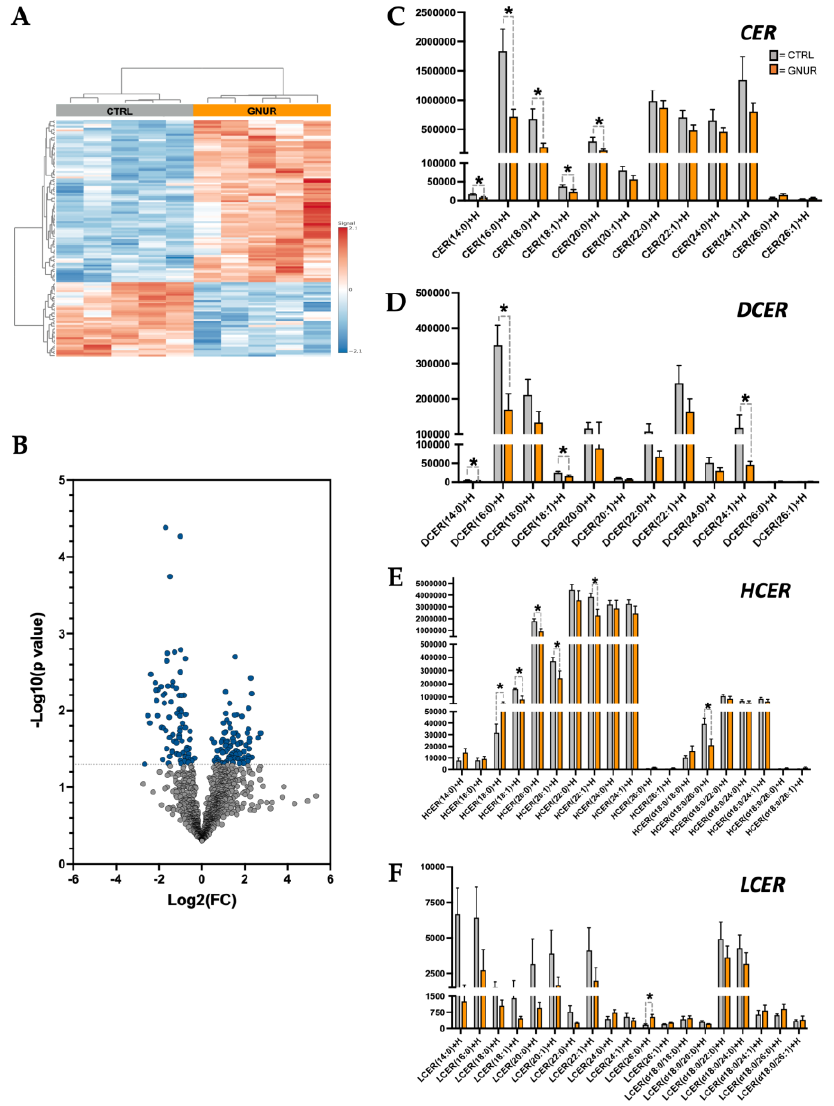
Figure 4. Lipidomics analysis of lipid species from the livers of GNUR- and CTRL-treated obese mice. ( A ) The heatmap of lipid species significantly changed in GNUR- and CTRL-treated obese mice. ( B ) Volcano plot of lipid species from lipidomics analysis of livers from GNUR- and CTRL- treated obese mice. ( C – F ) Sub-lipid species levels from four ceramide classes: ceramide (CER), dihydroceramide (DCER), hexosylceramide (HCER), and lactosylceramide (LCER) from GNUR- and CTRL-treated obese mice. [minimal n = 5 per group; *, p <